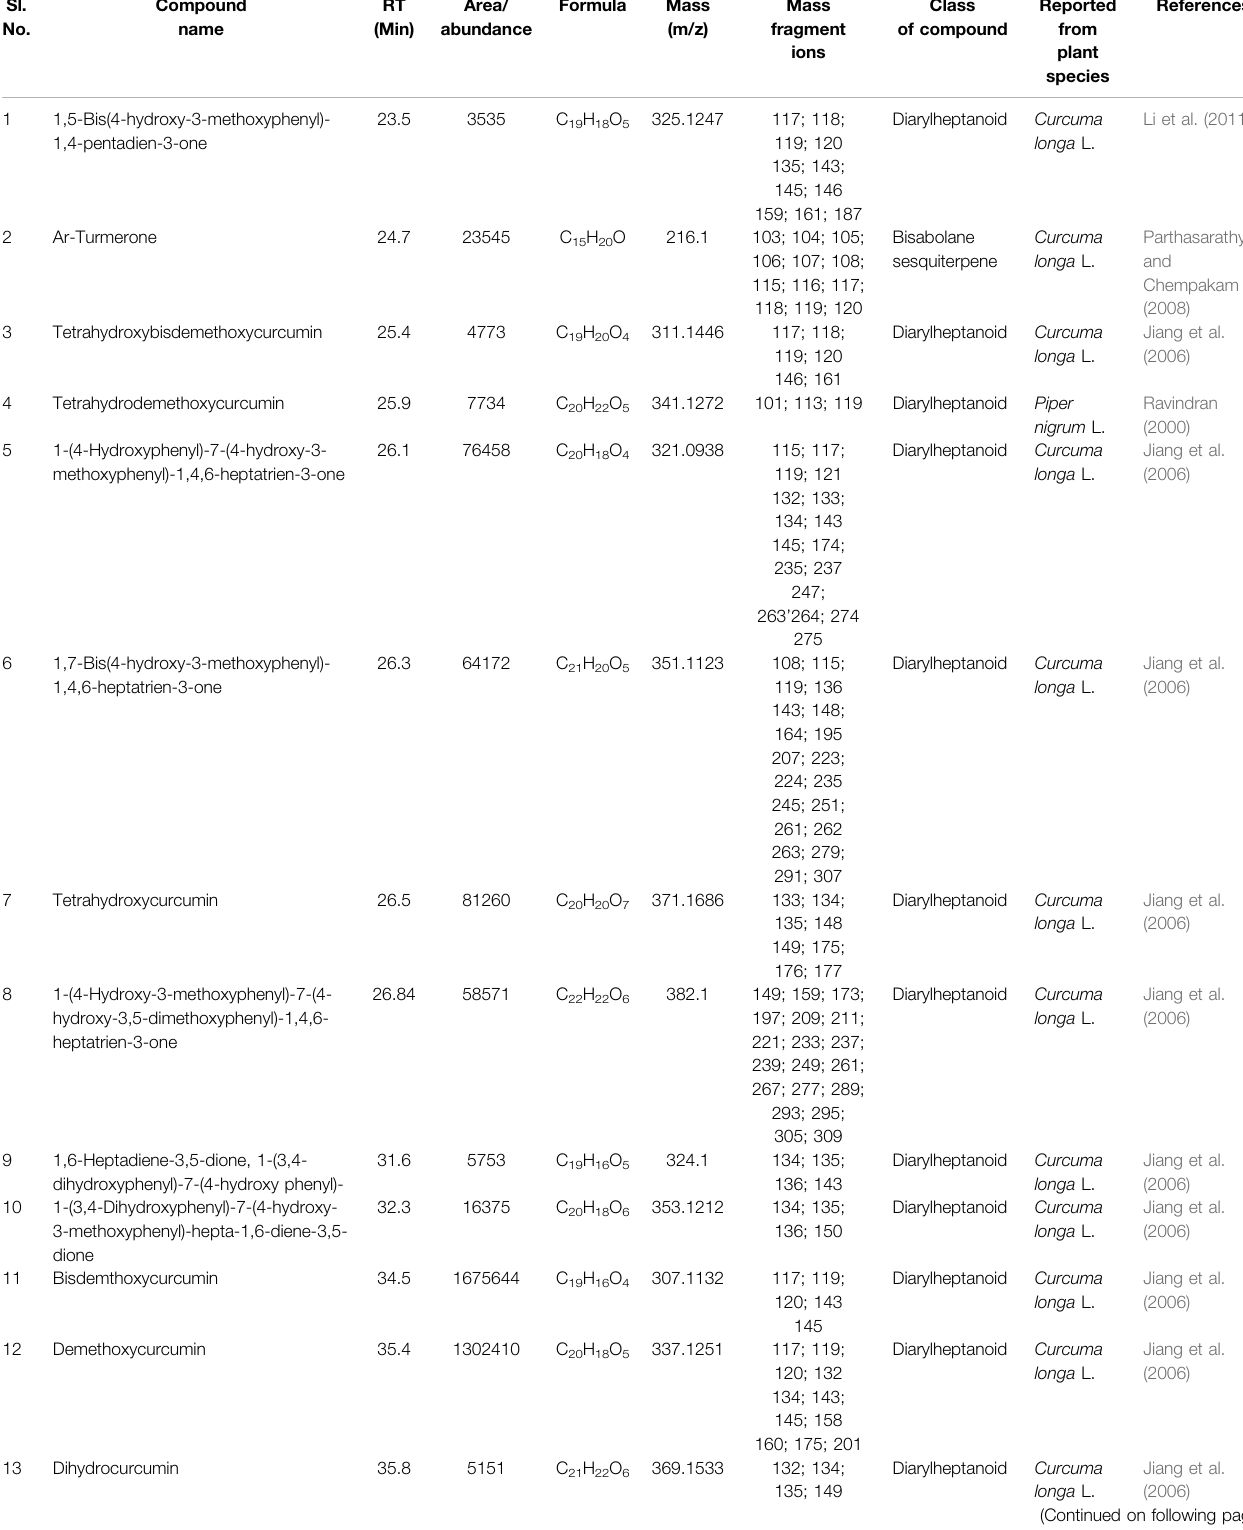
TABLE 8| Compounds commonly detected byLC-MS analysisofrhizomes extractofall seven cultivarsof Curcuma spp.: fi veof Curcuma longa L. (cvs. Alleppey Supreme, DuggiralaRed,Prathibha,Salem,andSuguna)andtwoof C.aromatica Salisb.(cvs.KasturiAraku,KasturiAvidi).Thestructuresforthecompoundsintheserialnumbers 10, 5, 6, 15, and 1 are given in Figure 4 (panels 13, 14, 15, 16, and 17 respectively). Sl.